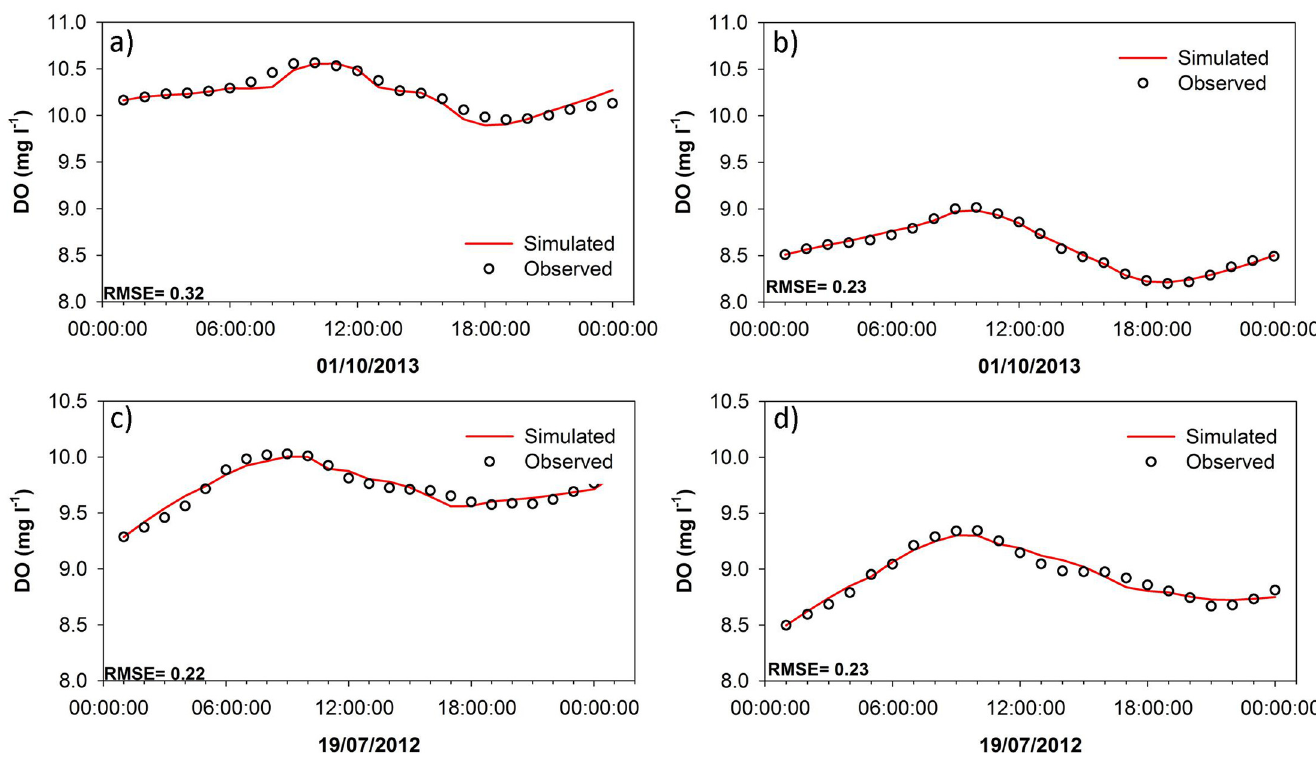
Fig 5. Simulated hourly DO versus the observed hourly DO at the upper catchment for a day during the non-growing season (01/10/2012) (a) and a day during the growing season (19/07/2012) (c). And hourly DO versus the observed hourly DO at the lower catchment for a day during the non-growing season (01/10/2012) (b) and a day during the growing season (19/07/2012) (d).